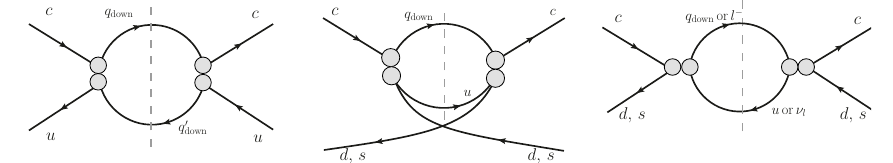
Figure 2. Diagrammatic representations of the spectator contributions resulting in the four-quark operators in mesons . From left to right: (a) weak exchange (WE), (b) Pauli interference (PI), (c) weak annihilation (WA).